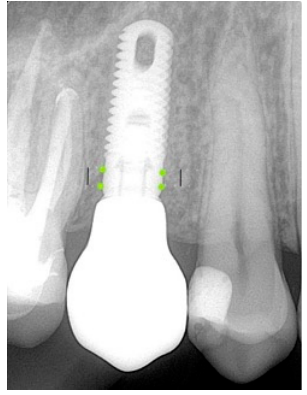
Figure 4. Measurement of the bone loss level.